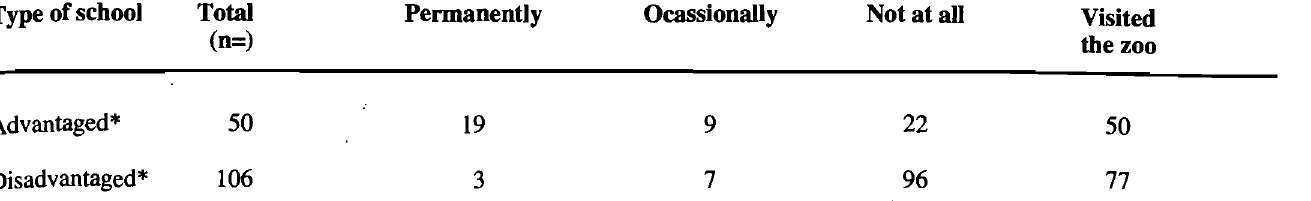
Table 3: Number of pre-schools that kept animals temporarily, permanently or not at all on the premises of the pre- school, or that visited the zoo "